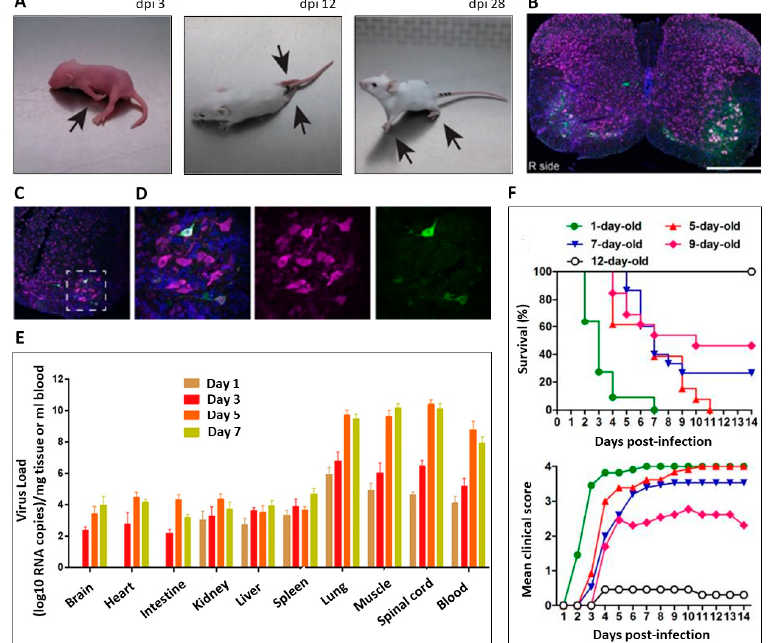
Figure 1. Contemporary strains of enterovirus D69 (EV-D68) cause paralysis in neonatal mice. ( A ) Examples of limb paralysis (arrows) in 3 different neonatal Swiss Webster (SW) mice following intracerebral (IC) injection of the contemporary EV-D68 strain MO/14-18947. Images are of mice at day post infection (dpi) 3, 12, and 28. (B) A cervical spinal cord section of a mouse at 100× original magnification following IC injection with EV-D68 MO/14-18947 that developed right forelimb paralysis on day 4 post-injection. Loss of motor neurons (green, labeled with choline acetyltransferase / ChAT) is observed in the right (“R side”) anterior horn, corresponding to the affected side. (C) 200× and (D) 600× images from a left anterior horn in an IC-injected mouse at 3 dpi before the onset of paralysis showing EV-D68 antigen in an intact cluster of motor neurons. The box in (C) represents the area imaged at 600× in (D). For all images, neurons (magenta) are labelled with NeuN, a general